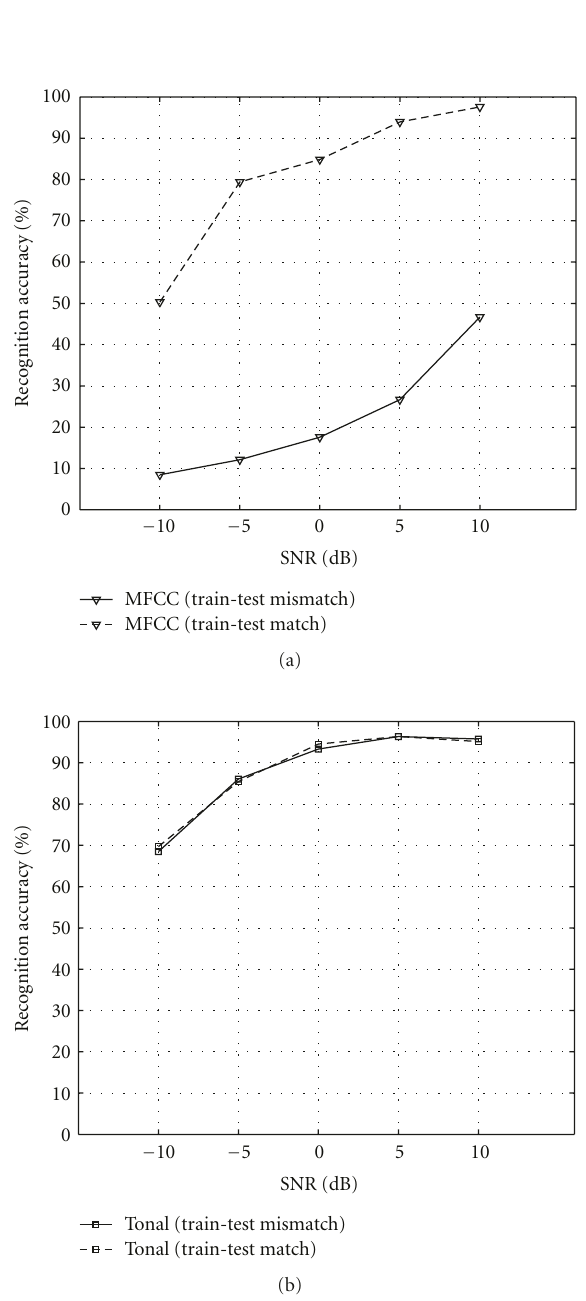
Figure 5: Bird syllable recognition accuracy on data corrupted by Waterfall noise obtained by the multi-condition model trained on Waterfall noise (train-test match) and White noise (train-test mismatch) and employing the MFCC (a) and the tonal-based (b)